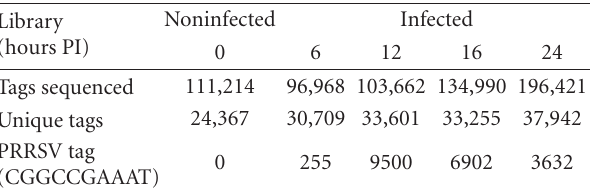
Table 1: Summary statistics of SAGE